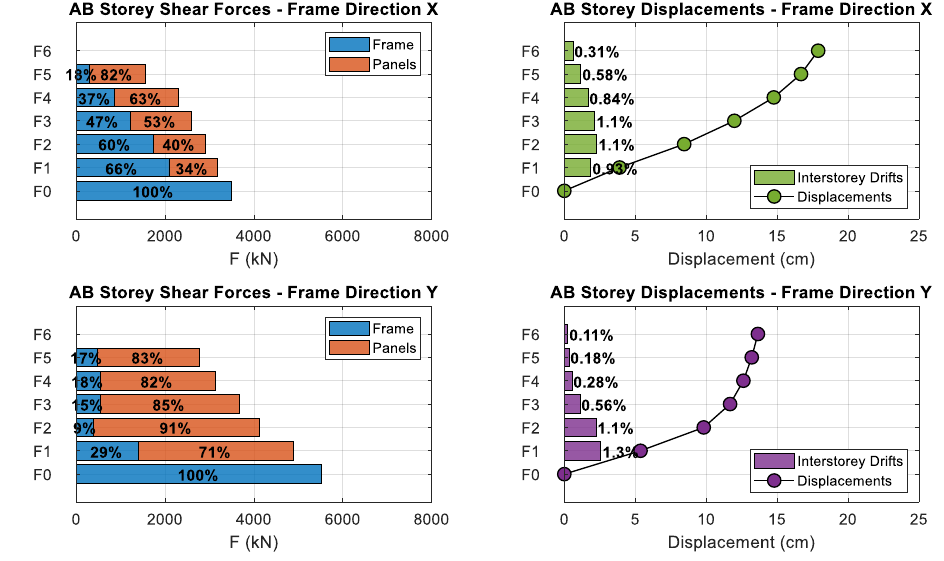
Figure 10. As-Built storey shear forces and displacements.